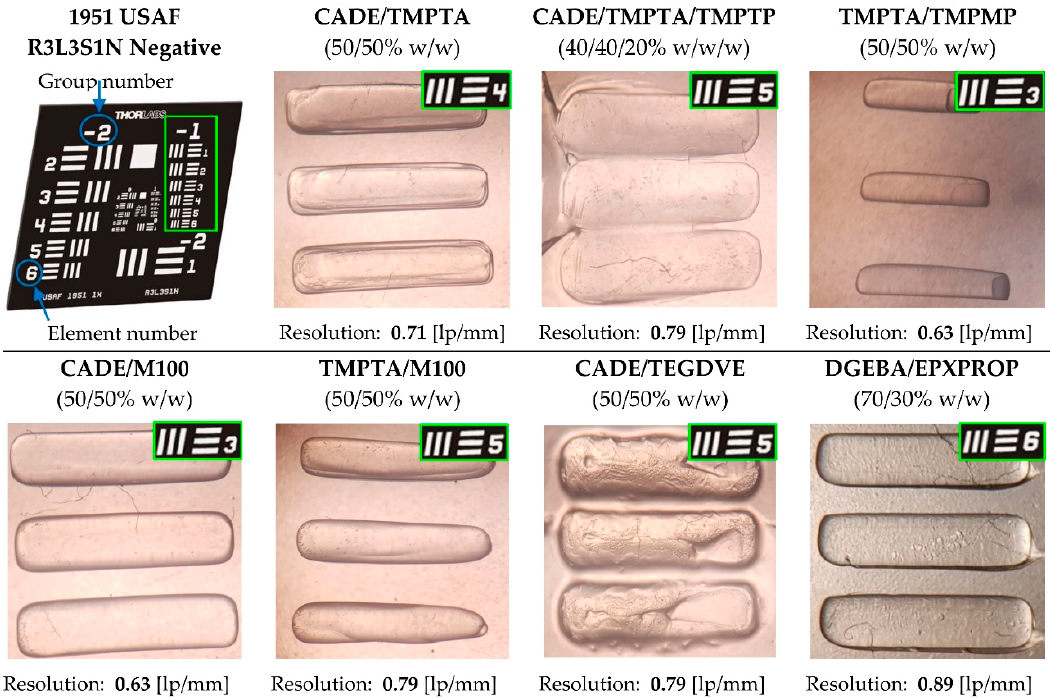
Figure 9. Determining optical resolution of printout of investigated compositions by imaging a USAF 1951 resolution test target. (The photo of the mask is from: https://www.thorlabs.com/newgrouppage9.cfm?objectgroup_id=4338.)